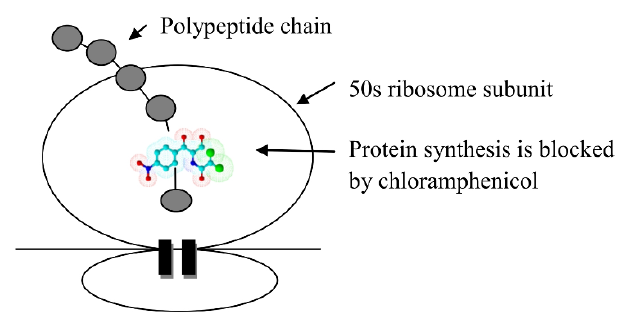
( b ) Figure 12. The chemical structure of chloramphenicol ( a ) and its derivative—azidamphenicol ( b ). The Mechanism of the Antibacterial Action of Chloramphenicol It was originally isolated from the bacterium Streptomyces venezuelae , by David Gottlieb. It appeared in clinical practice in 1949, under the trade name Chloromycetin. Azidamfenicol has a similar profile to chloramphenicol. Both drugs have been useful in treating ocular infections that were